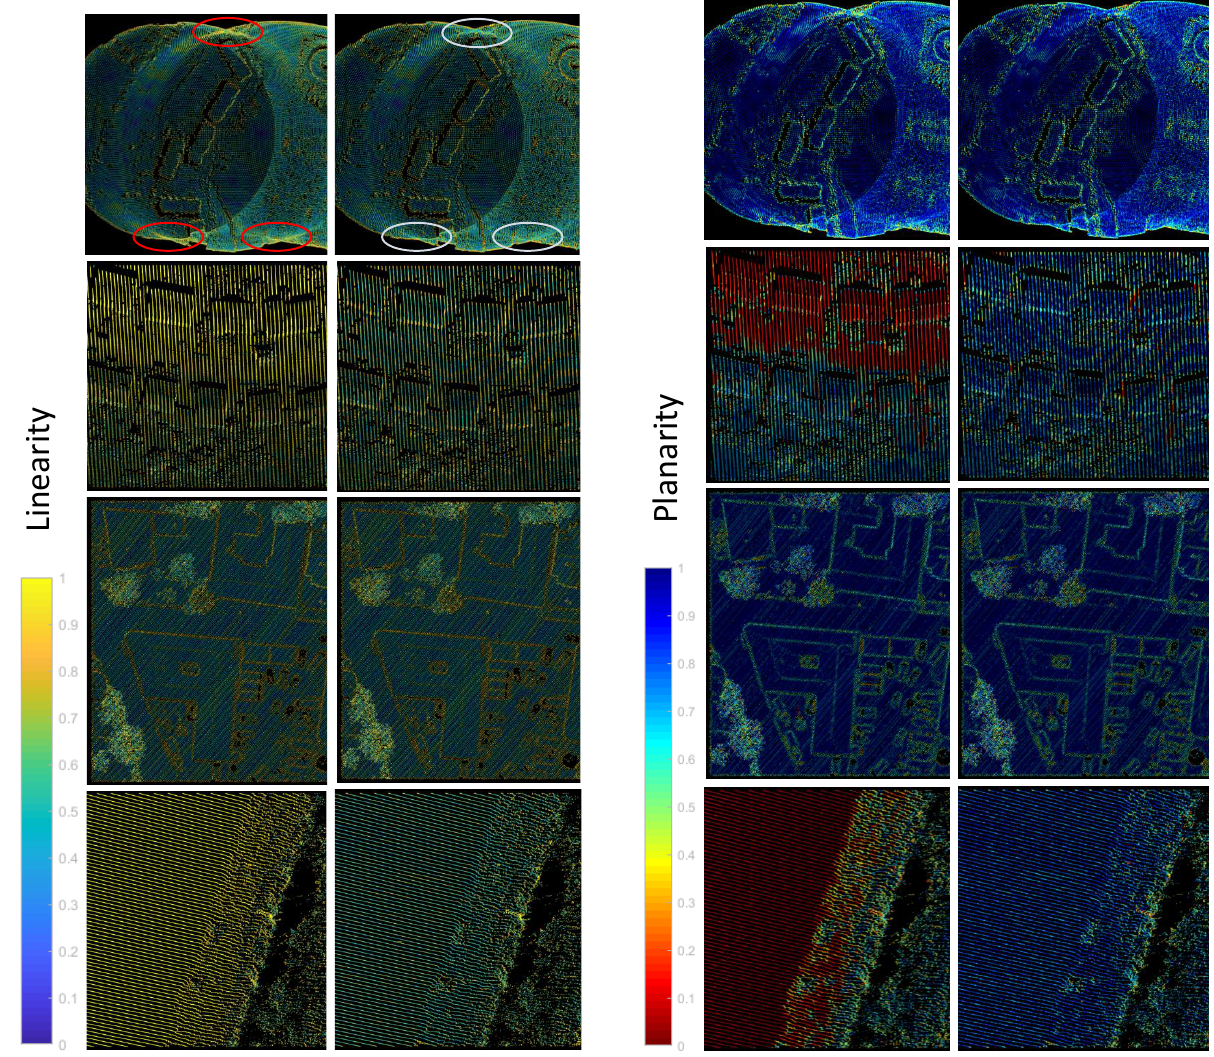
Figure 7. The linearity and planarity feature is highly influenced by the scan pattern if not compensated by the neighbourhood definition. This is visible in row 2 and 4. Left column: k NN16, right column: samp k NN16; Data set from top to bottom: ALS-PAL, ALS-OSC, ALS-ROT and